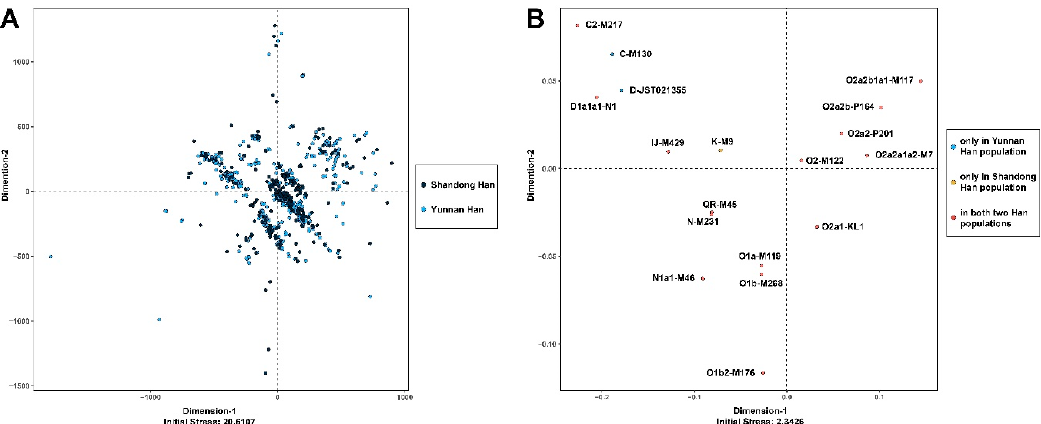
Figure 8. MDS plots on the individual level using 27 Y-STR loci and 24 Y-SNPs. ( A ) Plot for 27 Y-STR loci. Male individuals from Shandong Han population are labeled in navy blue, while those from Yunnan Han population are in light blue. ( B ) Plot for 24 Y-SNPs. Blue denotes male individuals from Yunnan Han population; yellow denotes those from Shandong Han population; jacinth denotes male individuals from both populations.